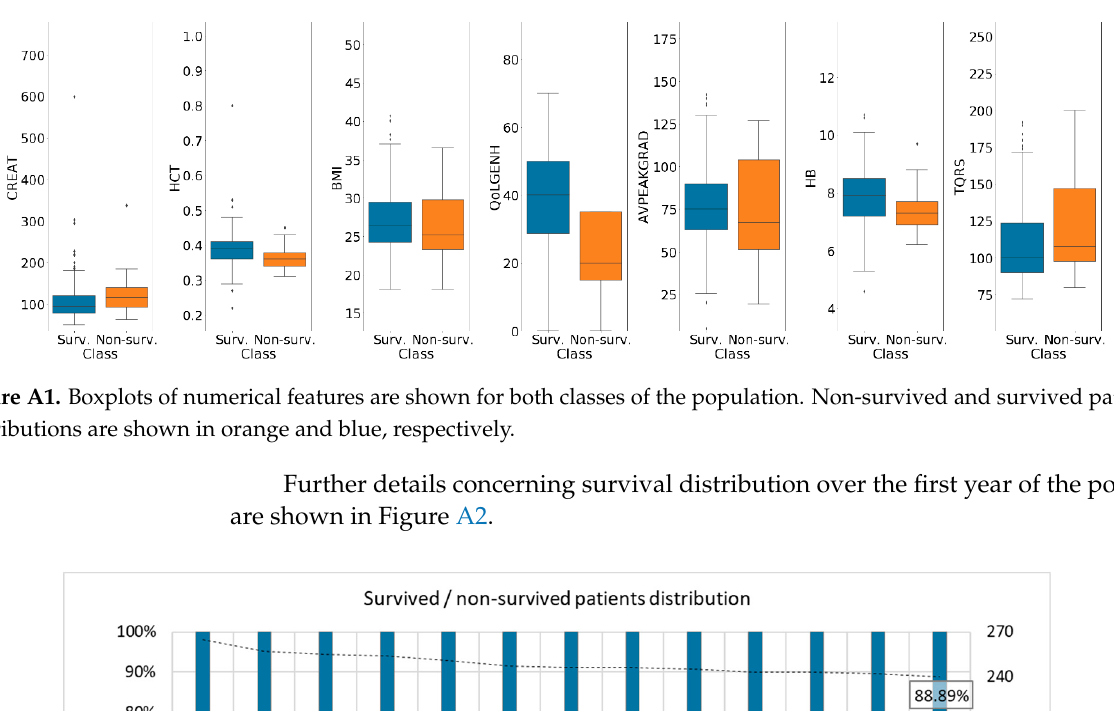
Figure A3. Survival and non ‐ survival rates per month. References 1.